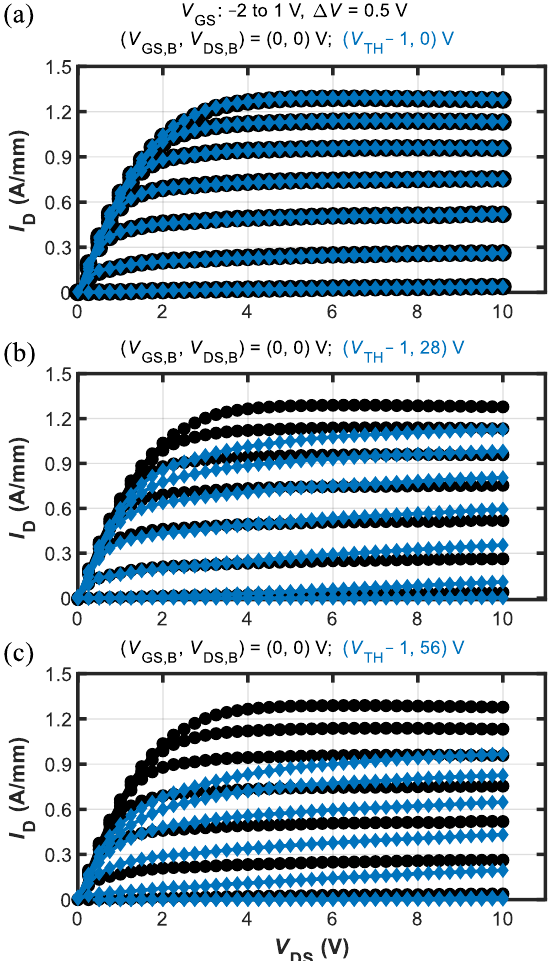
Figure 3. Pulsed I D - V DS characteristics obtained from different baselines for V GS = –2 to 1 V (Δ V = 0.5 V). Negligible gate-lag (assessed by pulsing from V GS,B = V TH – 1 V) is shown in panel ( a ); significant dispersion shown in panels ( b ) and ( c ) (assessed when pulsing from V GS,B = V TH – 1 V and V DS = 28 or 56 V) suggests current collapse was mainly induced by deep trap states in the buffer.